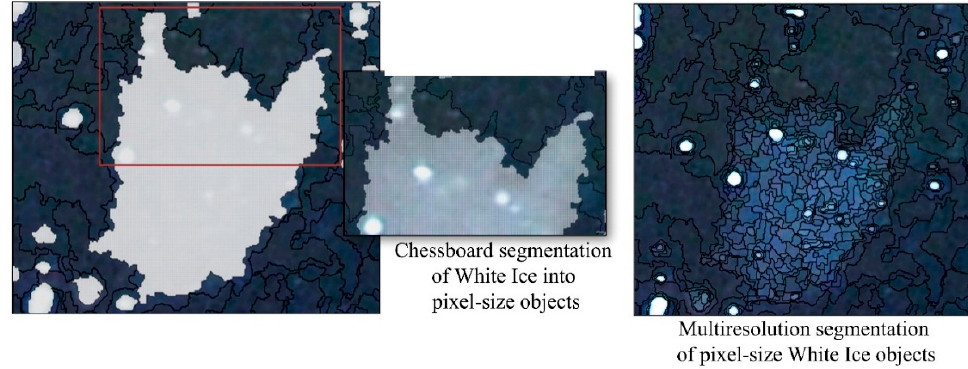
Figure 5. An example of chessboard segmentation to create pixel-size objects followed by multiresolution segmentation on White Ice image objects to identify bubble patches within the white ice region.